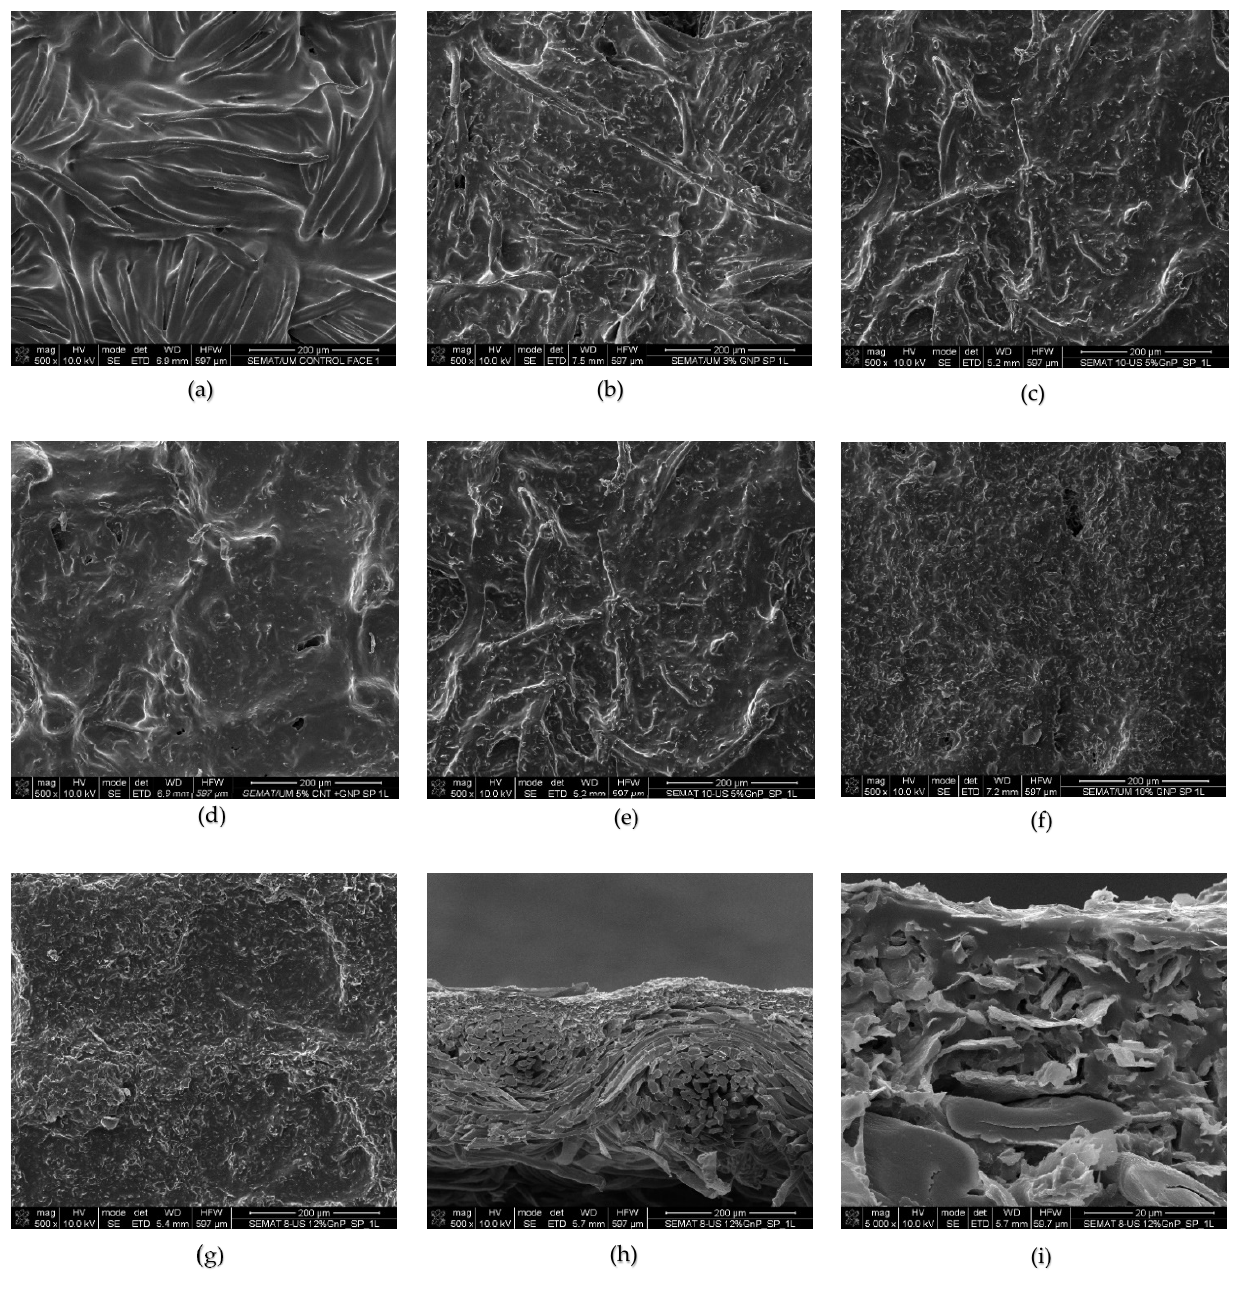
Figure 7. ( a ). Cotton with polymer; ( b ). 3% ( w / v ) GNPs; ( c ). 5% ( w / v ) GNPs; ( d ). 5% ( w / v ) CNTs + GNPs; ( e ). 7% ( w / v ) GNPs; ( f ). 10% ( w / v ) GNPs; ( g ). 12% ( w / v ) GNPs; ( h ). Cross section 12% ( w / v ) GNPs 1000 × ; ( i ). Cross section 12% ( w / v ) GNPs 5000 ×